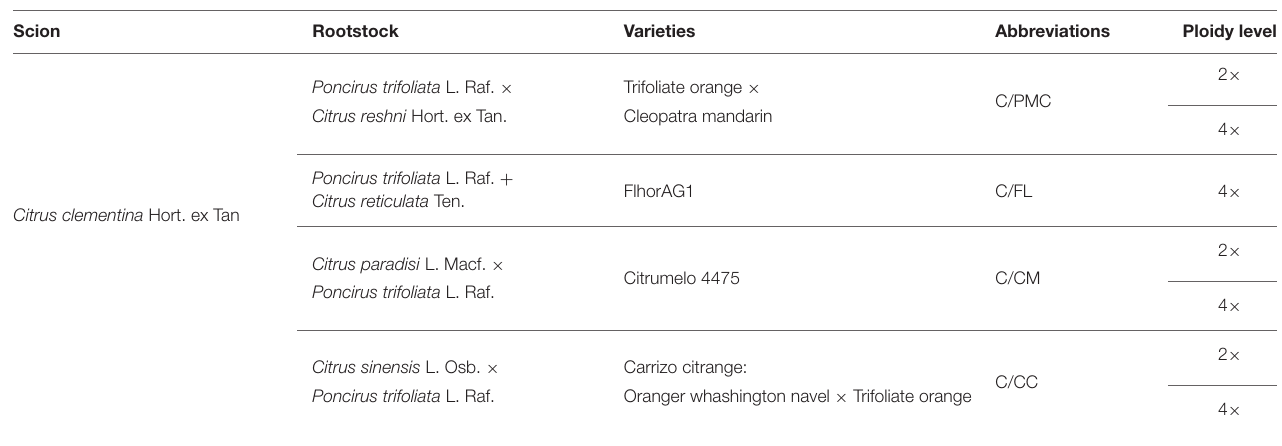
TABLE 1 | Description of scion/rootstock combinations.